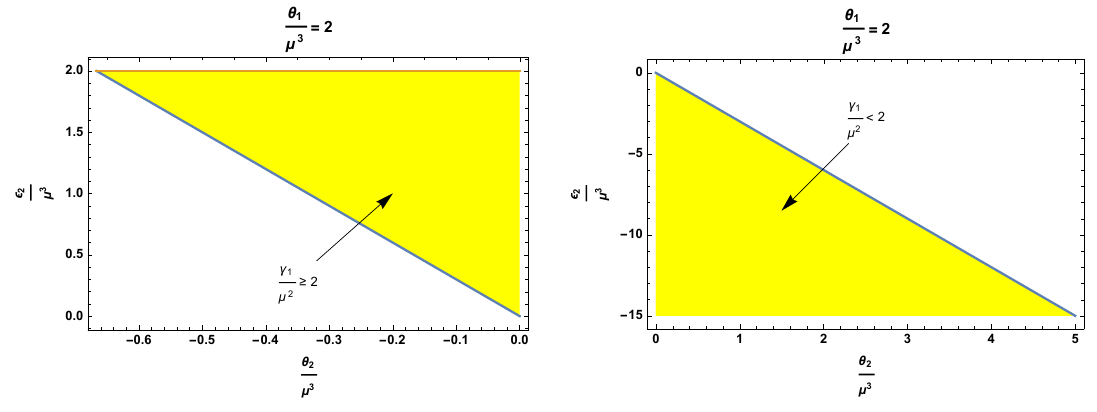
Figure 2 . Phase space of transports ˜ ǫ 2 and ˜ θ 2 for ˜ θ 1 = 2. The left figure corresponds to the region bounded between ˜ ǫ 2 < 2, ˜ ǫ 2 = figure represents the case ˜ γ 1 < 2 and ˜ θ 1 = 2. In this region ˜ ǫ 2 < 0 , ˜ θ 2 > 0 and ˜ ǫ 2 <